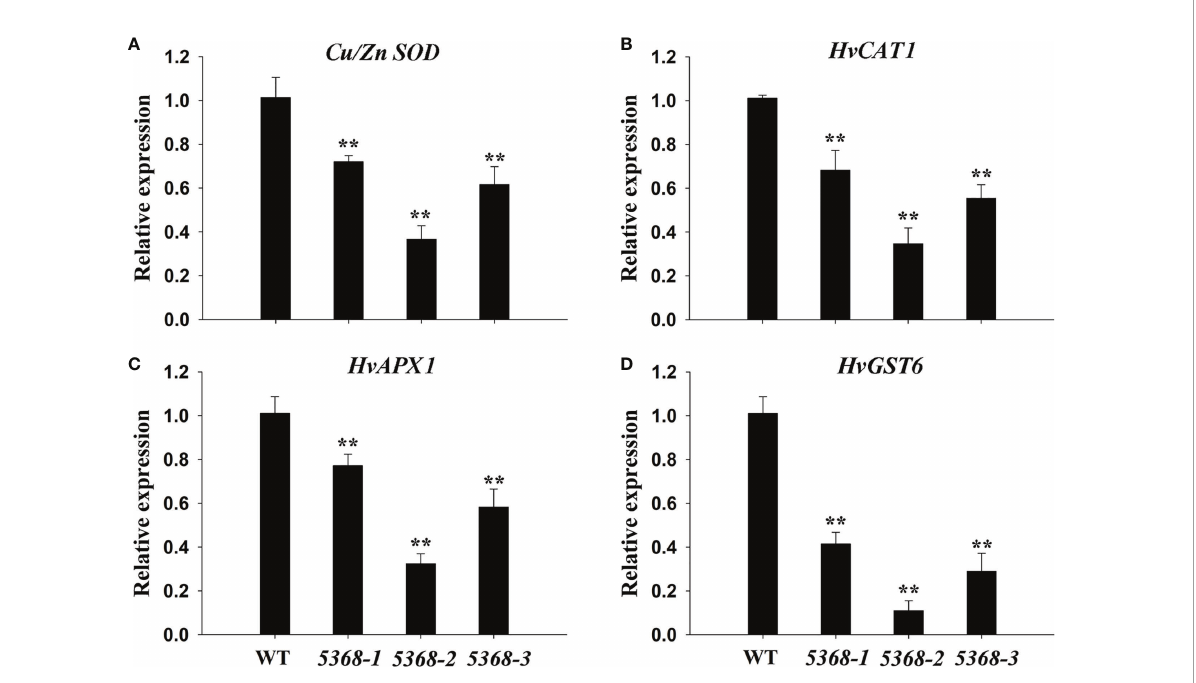
FIGURE 8 Relative expression of antioxidant enzyme genes in fl ag leaves of WT and LMM 5386 lines. (A) C U /Z N SOD , (B) H V CAT1 , (C) H V APX1 , and (D) H V GST6 . Values are means ± SD based on six replicates. Error bars indicate standard deviations. **P <